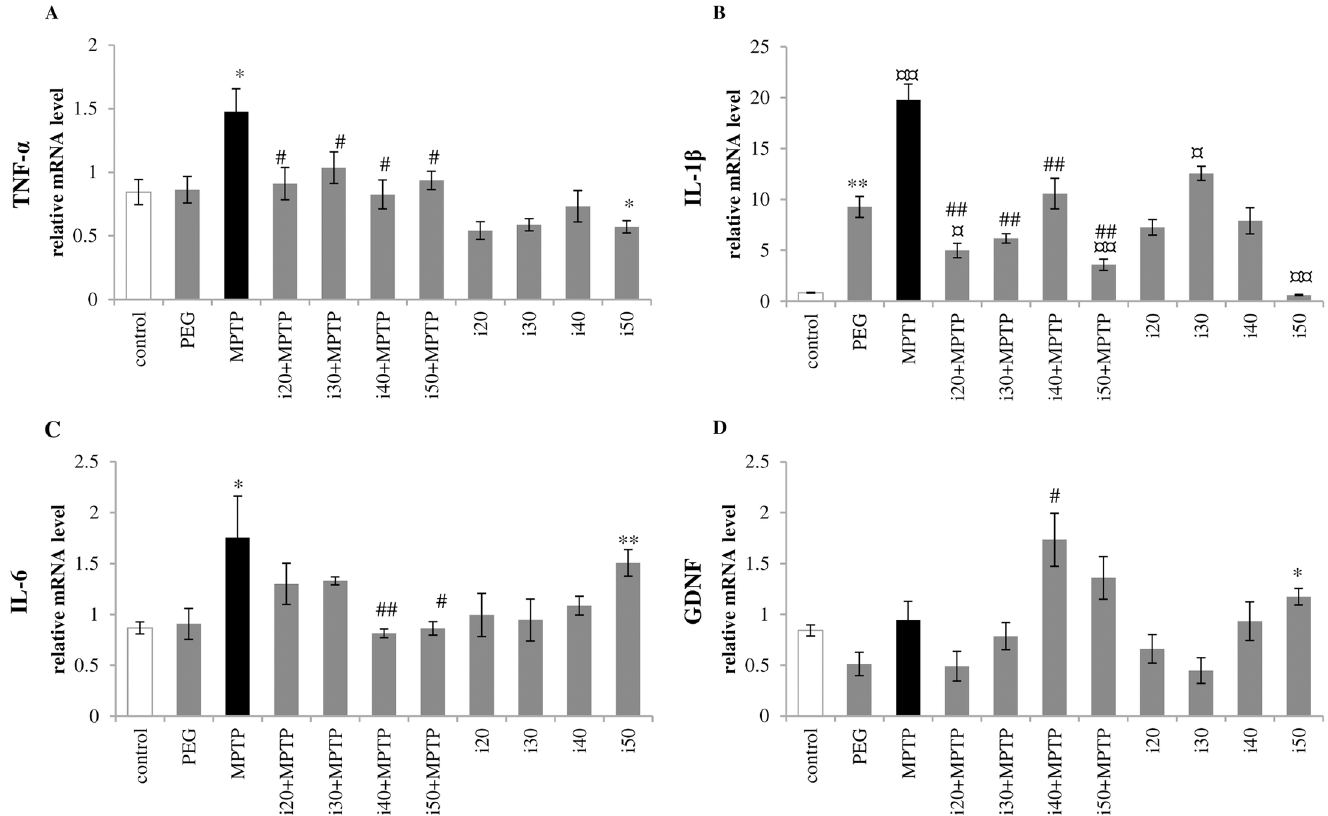
Fig 3. Effect of IBD on mRNA expression of pro-inflammatory cytokines and a trophic factor (GDNF). The mRNA expressionof (A) TNF- α , (B) IL- 1 β , (C) IL-6, and (D) GDNF in the striatum was examinedby real time RT-PCR. Abbreviations of groups of animals: control–saline-treated; PEG–vehicle- treated; MPTP–MPTP-intoxicated; i(20, 30, 40, or 50)+MPTP–IBD [20, 30, 40, or 50 mg/kg] and MPTP-treated; i(20, 30, 40, or 50)–IBD [20, 30, 40, or 50 mg/kg] treated. Data is given as the mean value ± SEM of five animalsper group ( * represents a significantdifference relative to the control group, * p < 0.05, ** p < 0.01; # representsa significantdifference comparedwith the MPTP group, # p < 0.05, ## p < 0.01; ¤ differs from vehicle-treated animals, ¤ p < 0.05, ¤¤ p < 0.01.Mann Whitney U test).